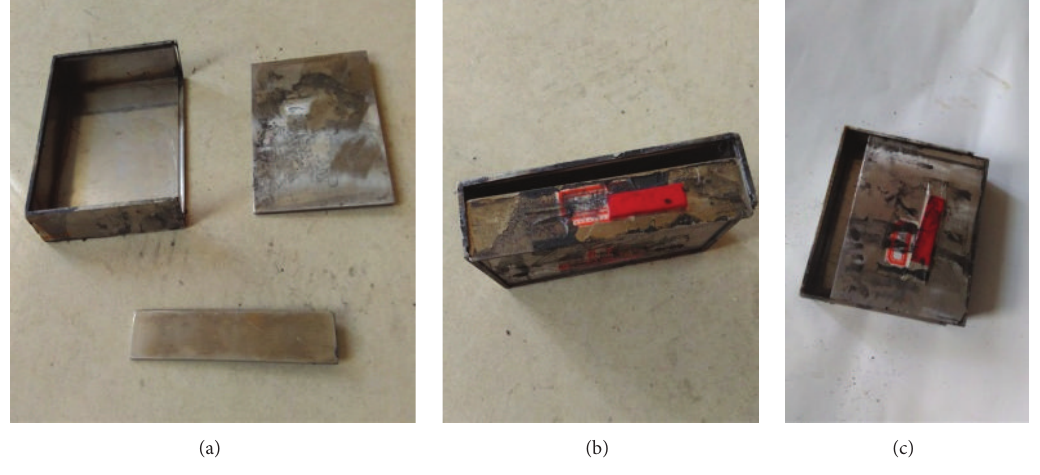
Figure 2: Mold for mixture latex after alignment of